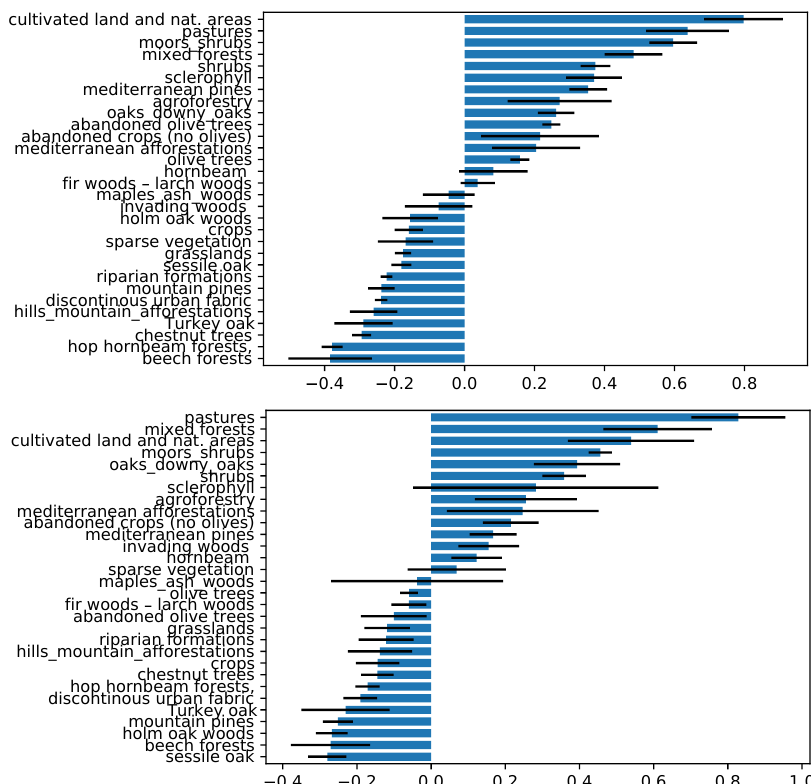
Figure 11. Partial dependence plot of the categorical variable corresponding to the local vegetation, for the RF model with global vegetation input set. Summer and winter are portrayed on the top and the bottom, respectively. The blue bars represent the means of the importance score among all the folds, and black lines represent the standard